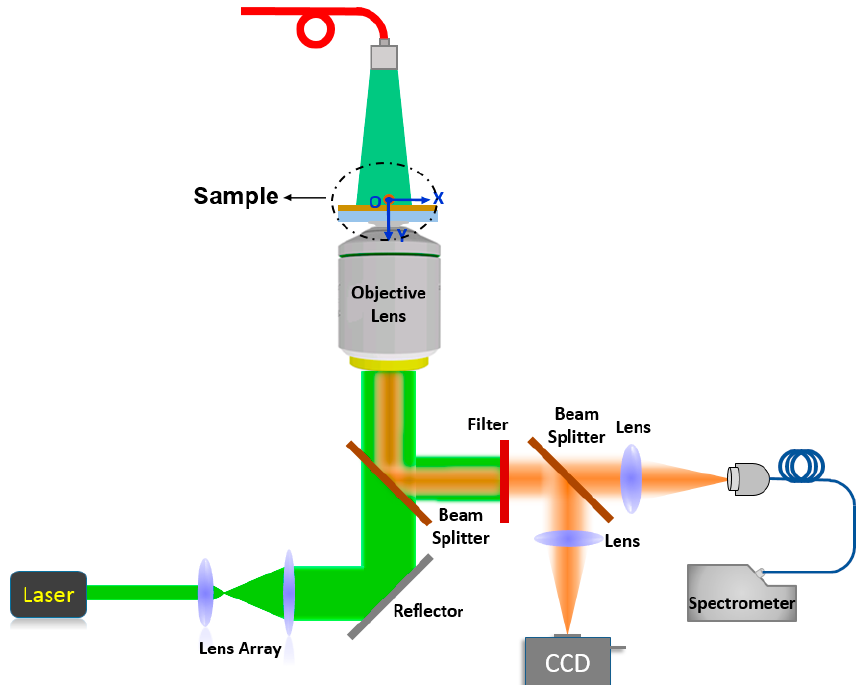
Figure 2. Experimental setup for single-fiber optical waveguide experiments (CCD here is shorted for Charge-coupled